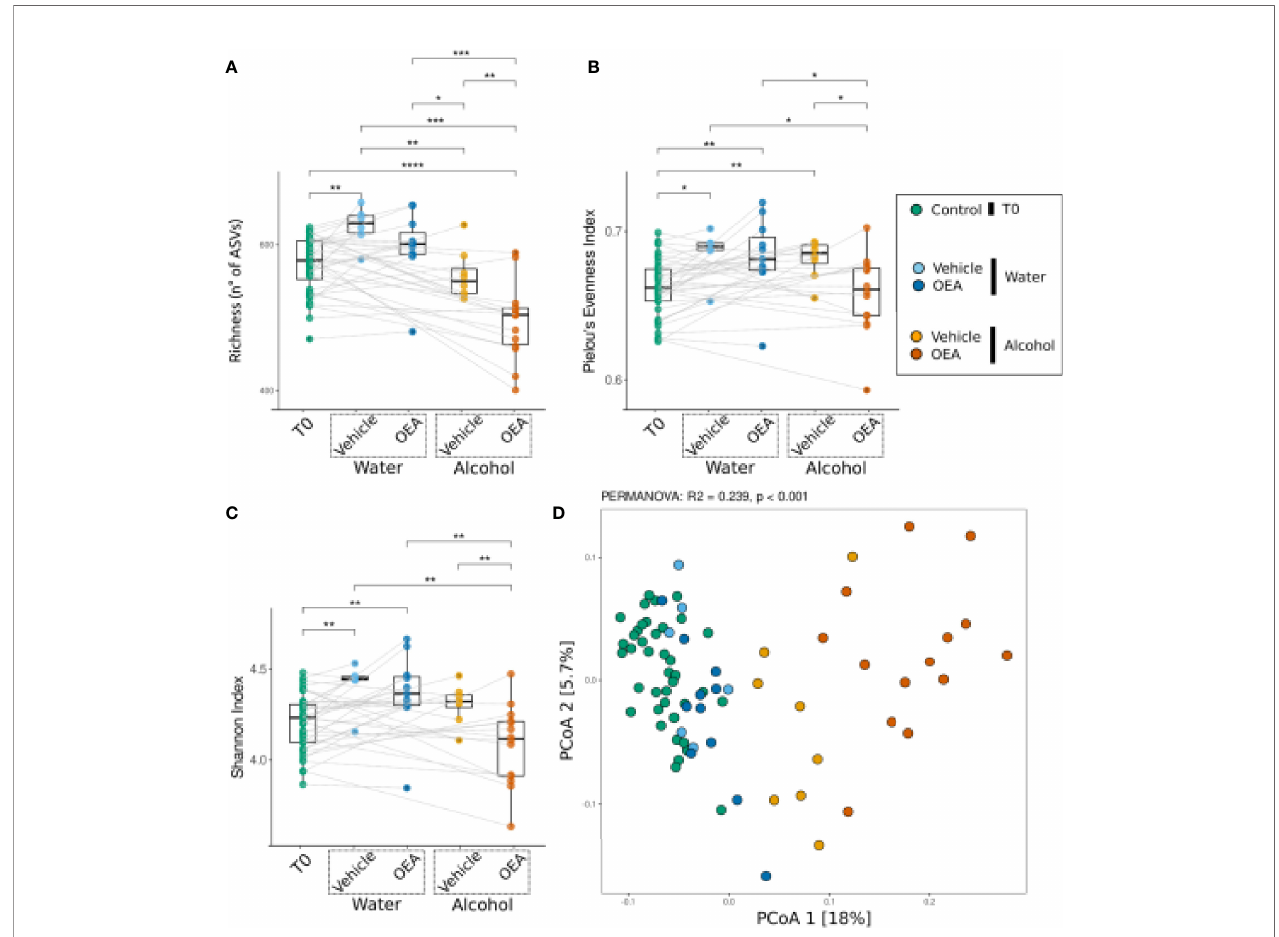
FIGURE 3 | Bacterial community response [ a -diversity: (A – C) ; b -diversity: (D) ] to alcohol binge drinking and oleoylethanolamide (OEA) treatment. (A) Richness (number of different ASVs), (B) Pielou ’ s evenness index (equitability of the distribution of relative abundances among ASVs), and (C) Shannon index (diversity of the community) as measures of a -diversity. Differences between groups were tested by Wilcoxon rank-sum test and reported as notation on the plot (* p -value < 0.05; ** p -value < 0.01, *** p -value < 0.001, **** p -value < 0.0001). Dotted lines connect the data from the same animal at the two time points for each treatment. (D) b - Diversity analysis with PCoA ordination among all samples, using the Bray – Curtis distance measure. Notation above the plots reports the result of the PERMANOVA test. T0 group, n = 40; water + vehicle group, n = 6; water + OEA group, n = 11; alcohol + vehicle group, n = 8; alcohol + OEA group, n = 14.